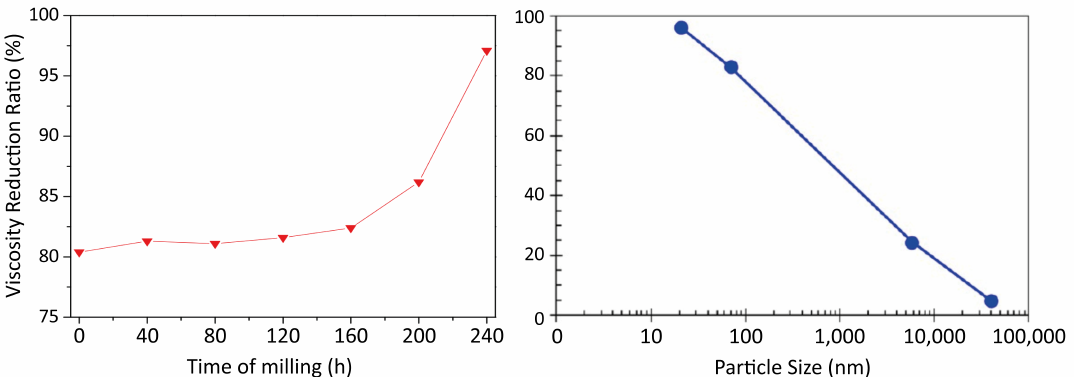
Figure 42. Viscosity reduction ratio of nano-NiWMoC catalyst synthesized at different milling times ( left ) and viscosity reduction ratio vs. particle size ( right ). Figures reproduced from Refs. [144] (left) and [149] (right).